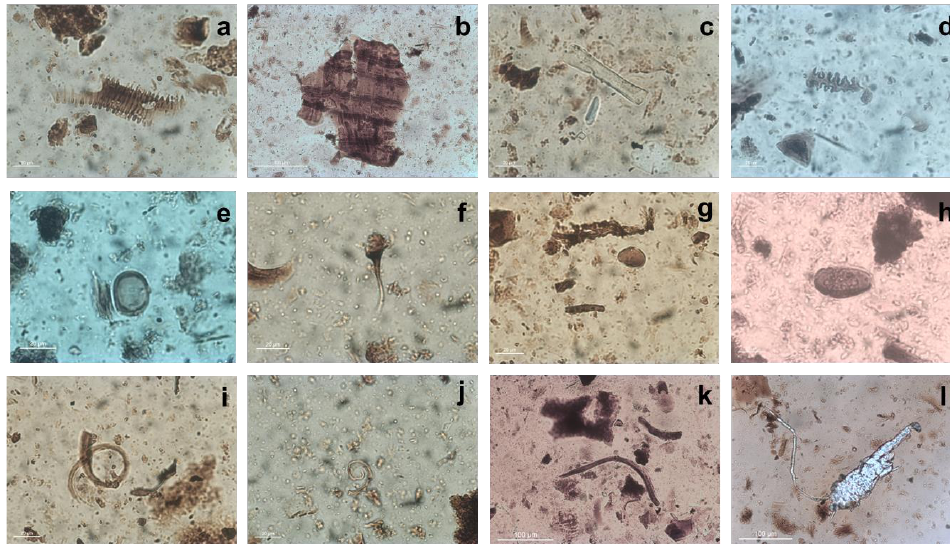
Figure 6. Micro-particles present in the carbonized faeces: ( a , b ): unknown tissue fragments; ( c ): elongate plant tissue; ( d ): dendric plant tissue; ( e ): fungal spore of Glomus -type (HdV-1103); ( f ): a spore filament; ( g ): cf. HdV-123; ( h ): cf. HdV-368; ( i – k ): unknown elongated remains; ( l ): remains of a crustacean.